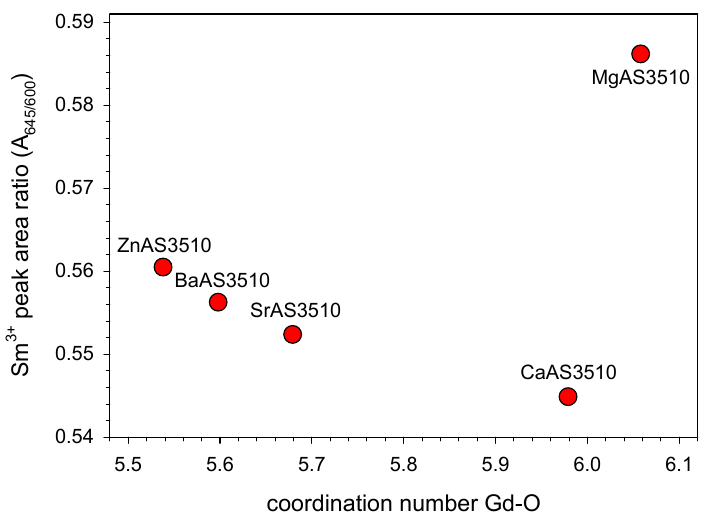
Figure 3. Sm 3+ emission peak area ratio of the peaks at 645 and 600 nm in dependence of the rare earth (Gd 3+ ) coordination number with oxygen from molecular dynamics simulations for the investigated aluminosilicate glasses. The lowest peak area ratio corresponds to the highest average symmetry at the rare earth sites in the glass structure, which is found at a coordination number of around 6. Table 3. Network modifier (NM) coordination according to molecular dynamic simulations. Upper part of the table: the coordination numbers (CN) and distances of the network modifying ions with oxygen in their first coordination sphere. Lower part: CN with Al 3+ , Si 4+ , and network modifier cat- ions in the second coordination sphere. In the lower part, the percentages of the different cation coordinations are also given.